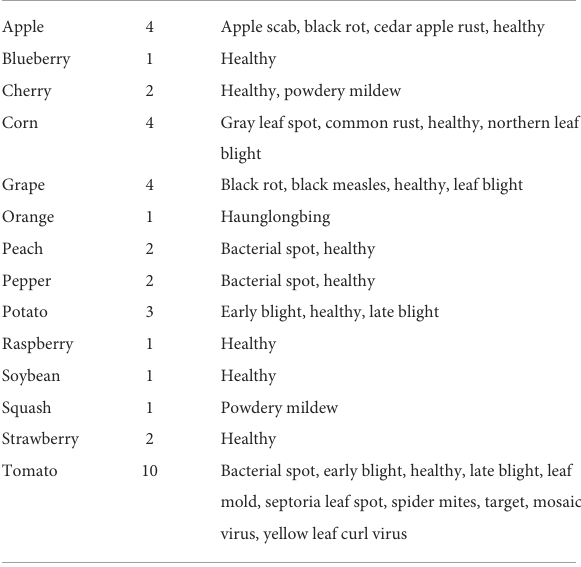
TABLE 1 The 14 species and 38 categories in PV.